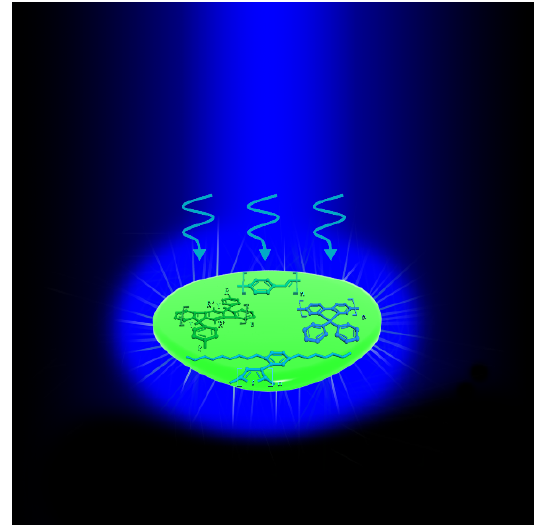
Figure 1. Schematic diagram of conjugated polymer lasers.